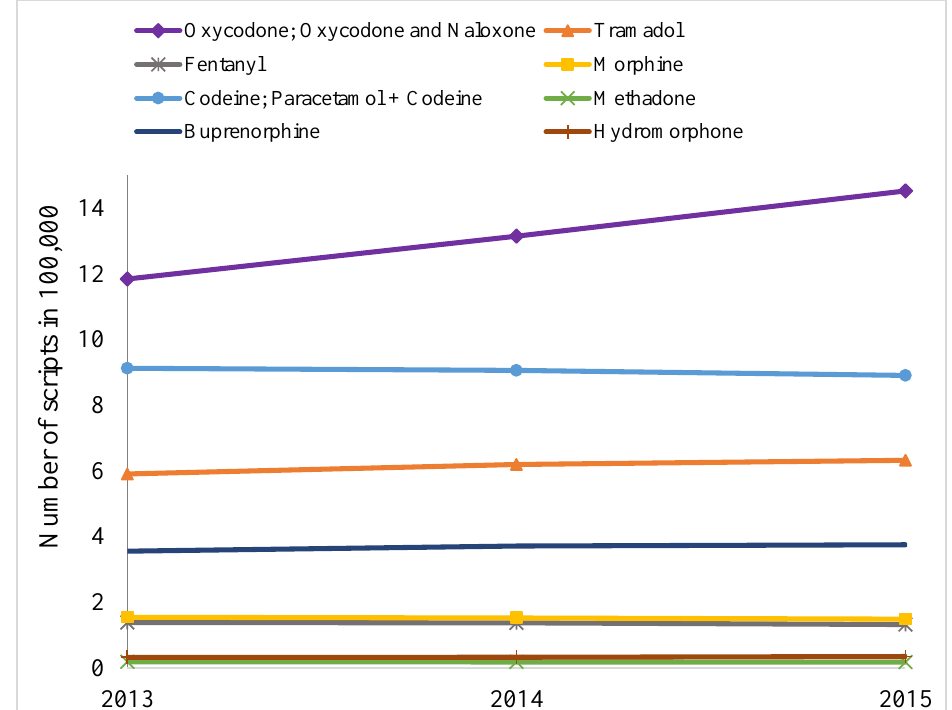
Figure 1. Annual trends in number of scripts during 2013 – 2015.